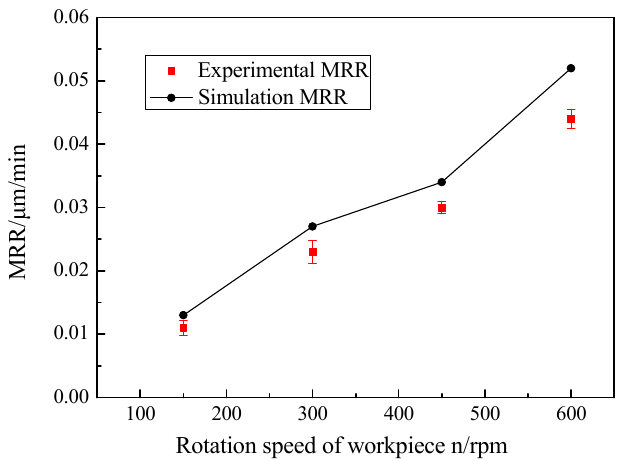
Figure 9. Effect of workpiece rotation speed on MRR.